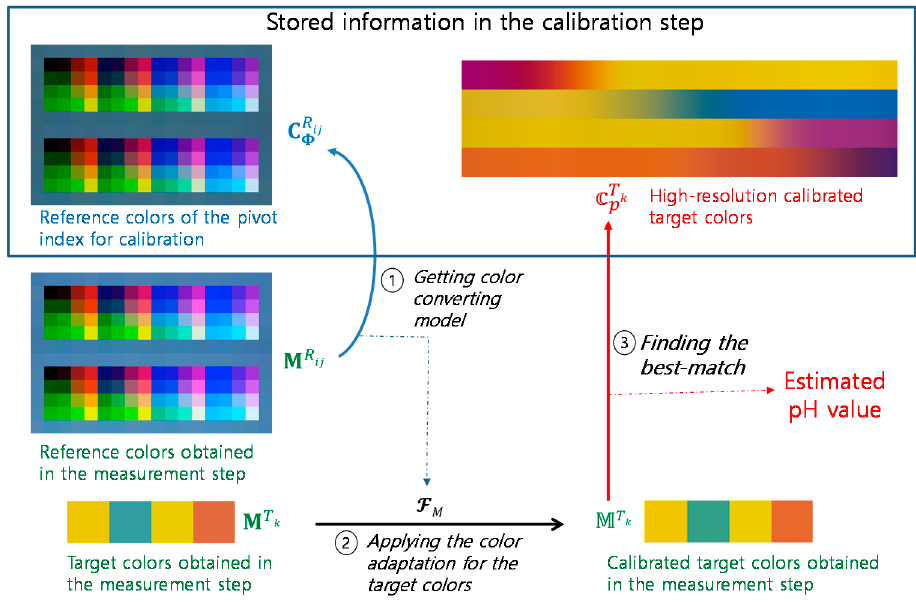
Figure 10. Overall procedure performed in the measurement step.